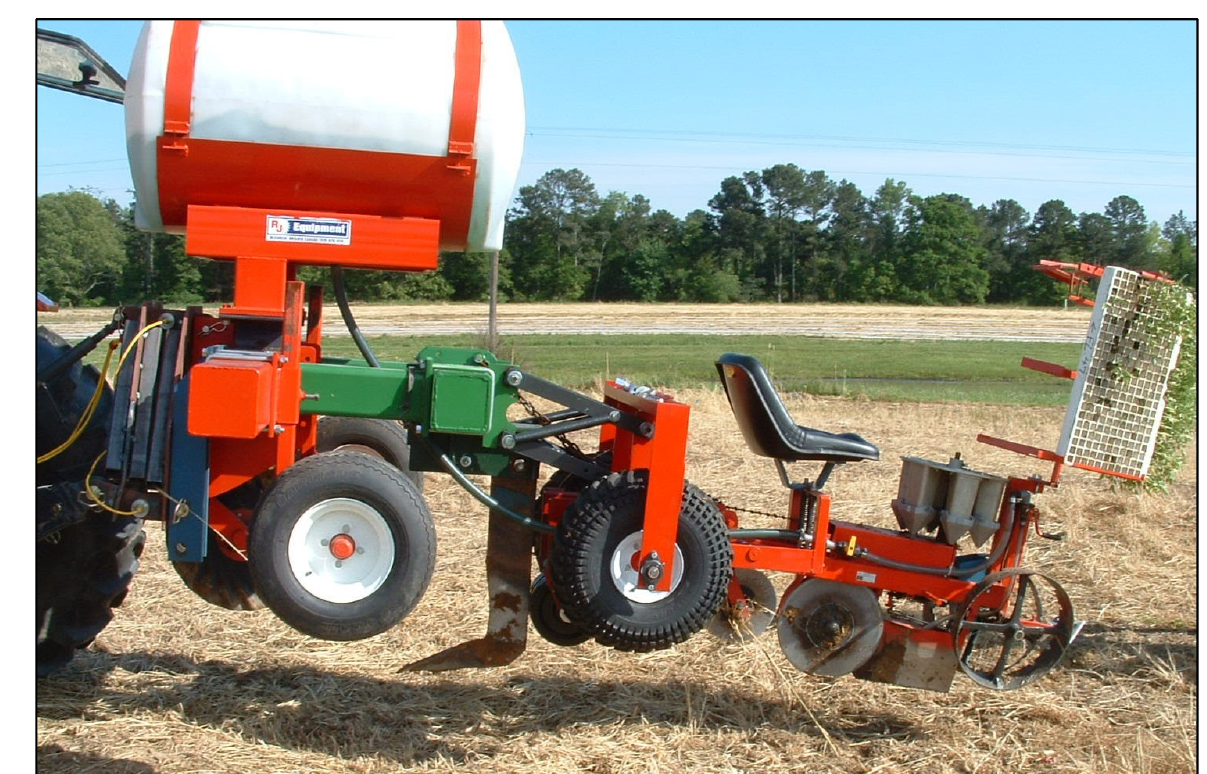
Figure 7. Modified RJ transplanter with added subsoiler shank to alleviate soil compaction while planting cantaloupe seedlings.